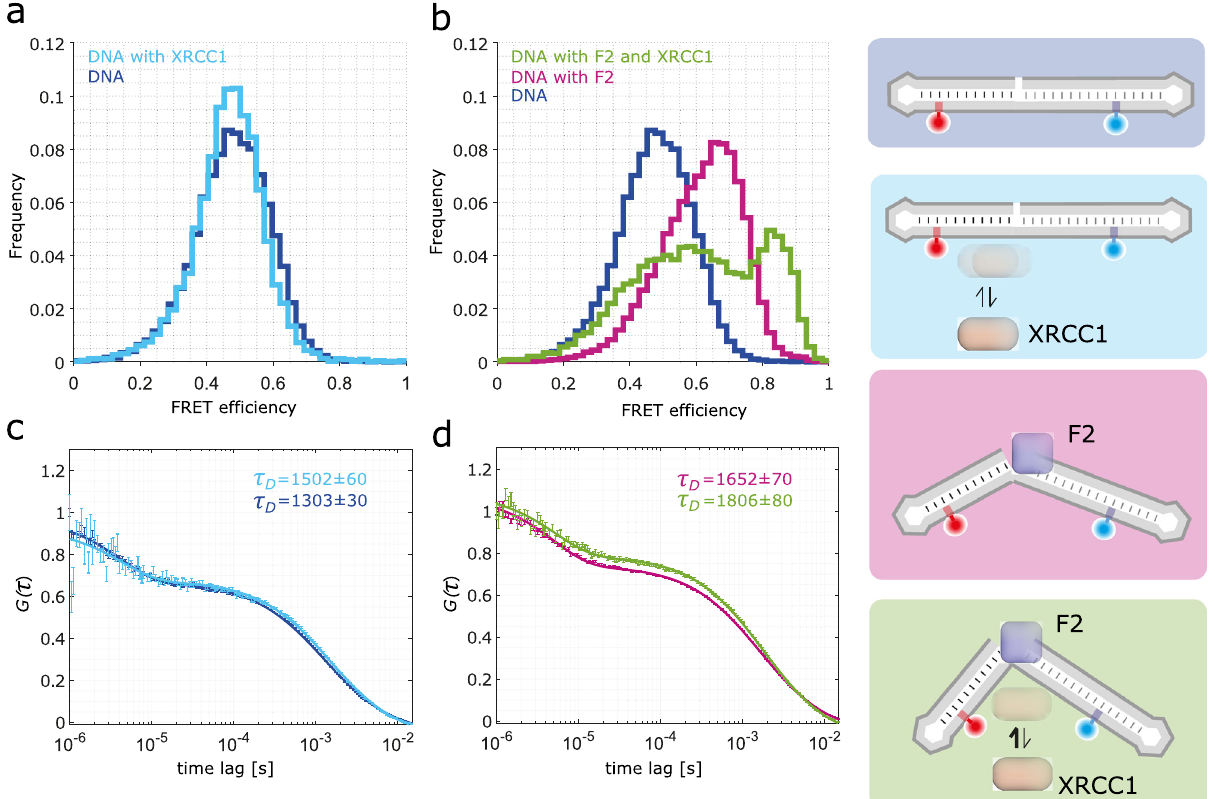
Fig. 7 | smFRET measurements probing the DNA conformation in presence of XRCC1. a smFRET ef fi ciency histogram of nicked DNA (blue) and nicked DNA in presenceof1 µ M XRCC1(lightblue); b smFRETef fi ciencyhistogramofnickedDNA (blue),nicked DNAinpresenceof 10 µ M F2 (magenta)and nicked DNA in presence of 10 µ M F2and 1 µ M XRCC1 (dark green). c , d FRET-FCSresults for data in a and b,